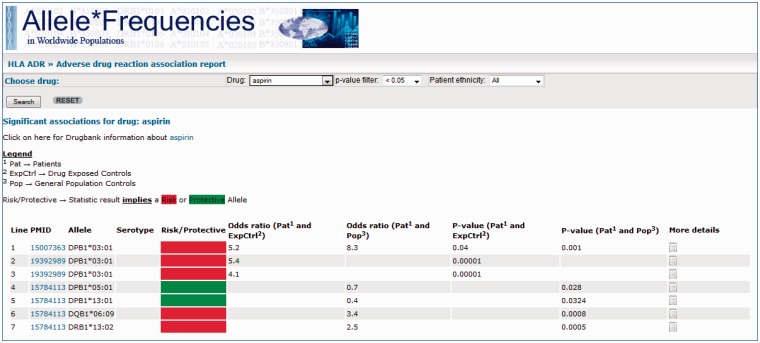
Screenshot of the AFND ADR reports page from a search for drug = aspirin, with the
other options remaining at their default settings (P < 0.05 and
no restrictions on patient ethnicity). A link is provided to the DrugBank page for
the drug underneath the search bar. Much like the HLA-ADR query page, the summary
table of results show the PubMed/MEDLINE link, the associated allele, the
statistical data and a link to the ‘More details’ page where full details about the
association can be found. In addition, a ‘risk/protective’ allele assignment is
given (red or green box) based on the proportion of carriers of the allele in the
patients group compared with the control group.